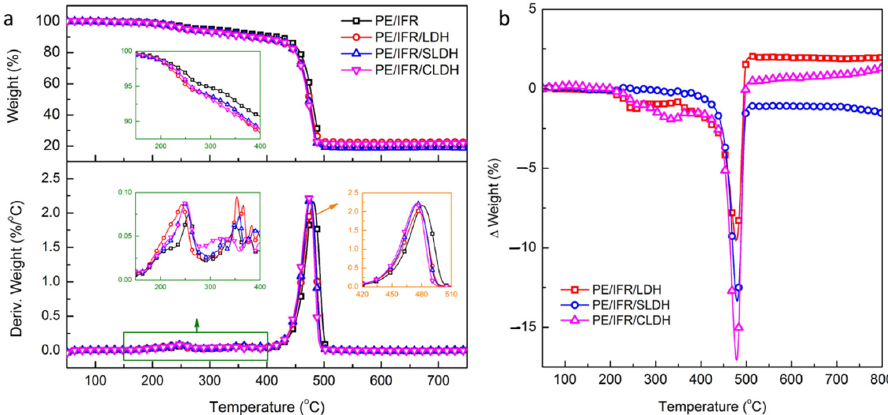
Figure 3. ( a ) TG curves and ( b ) Δ Weight versus temperature curves of